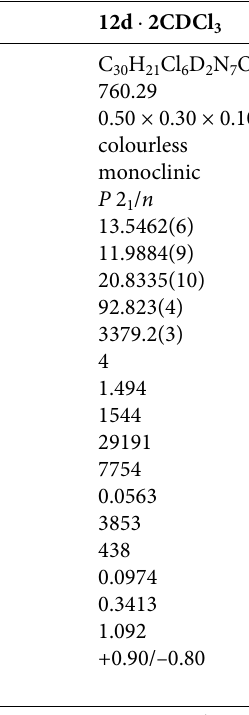
Table 7. Crystal data and structure refinement details for com- pound 12d · 2CDCl 3